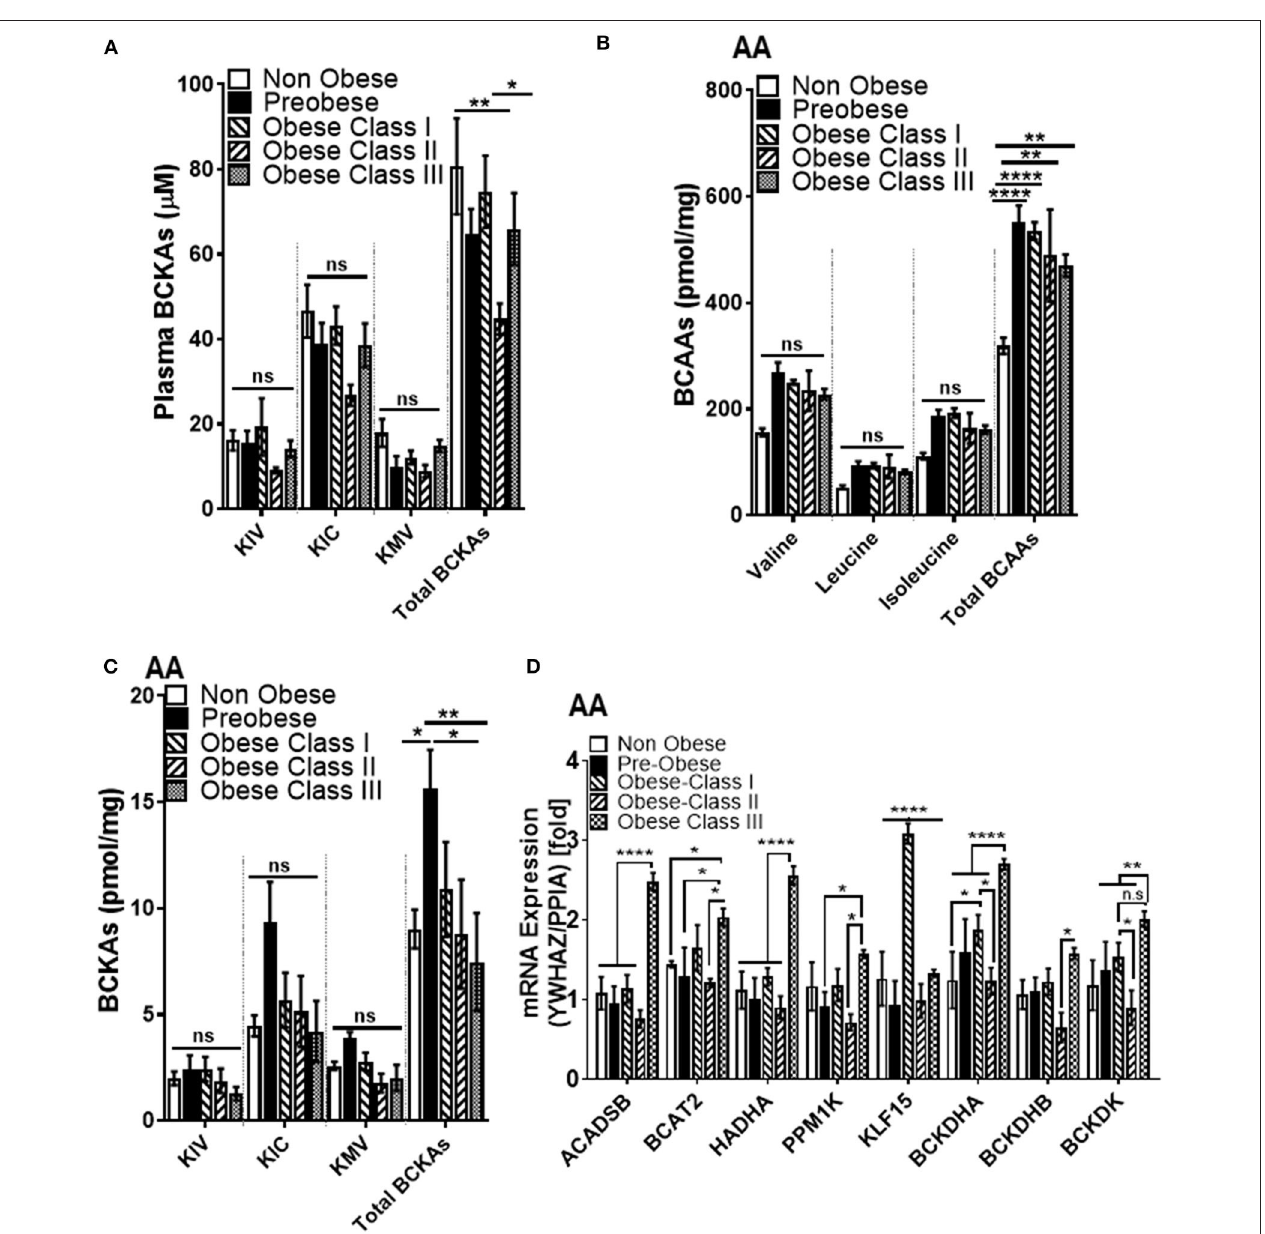
FIGURE 4 | Intramyocellular BCAAs and BCAA catabolic enzyme mRNA expression are increased in the AA tissues of cardiac surgery patients with severe obesity. (A) Free plasma BCKA levels measured by UPLC MSMS in the non-obese ( n = 9), pre-obese ( n = 10) and class I obese ( n = 10), class II obese ( n = 8) and class III obese ( n = 10) cardiac surgery patients. Intracellular (B) BCAAs and (C) BCKAs measured by UPLC MSMS in the AA of non-obese ( n = 5), pre-obese ( n = 5), class I obese ( n = 5), class II obese ( n = 5) and class III obese ( n = 5) cardiac surgery patients. (D) Quantification of ACADSB, BCAT2,HADHA, PPM1K, KLF15, BCKDHA, BCKDHB, and BCKDK mRNA expression corrected to YWHAZ and PPIA levels (39) in the AA of non-obese ( n = 6), pre-obese ( n = 6) and obese class I ( n = 6), class II ( n = 6) and class III ( n = 6) cardiac surgery patients. Statistical analysis was performed using a two-way ANOVA followed by a Tukey’s multiple comparison test; * p < 0.05, ** p < 0.01, **** p < 0.0001 as indicated (40).